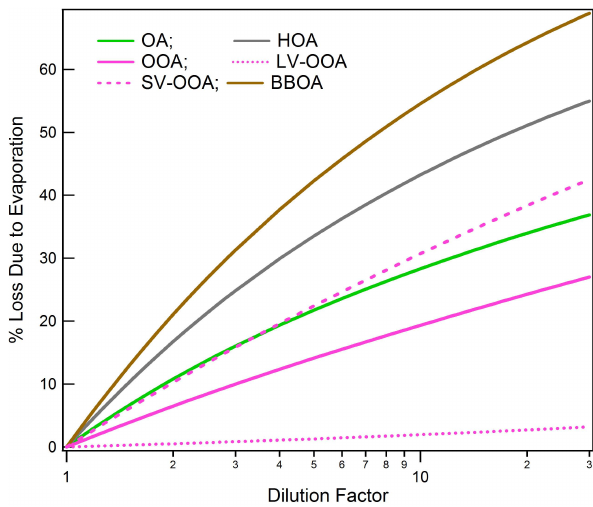
Fig. 6. The E loss (i.e. the additional mass loss due to evaporation af- ter dilution) is shown as a function of the dilution factor for the vari- ous campaign average OA factors (assuming 1H vap